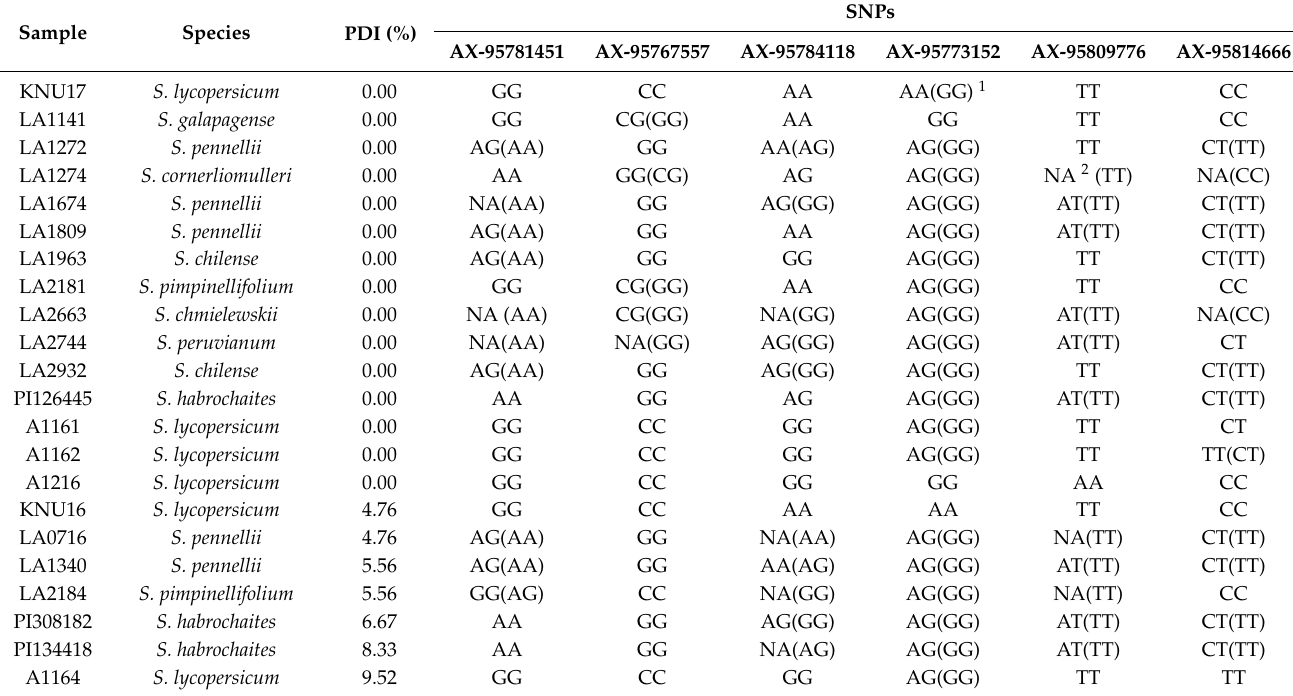
Table 4. Comparisons between the results from the Axiom ® Tomato Genotyping Array and the PCR- based marker cleaved amplified polymorphic sequence and derived cleaved amplified polymorphic sequence genotyping for six single nucleotide polymorphisms